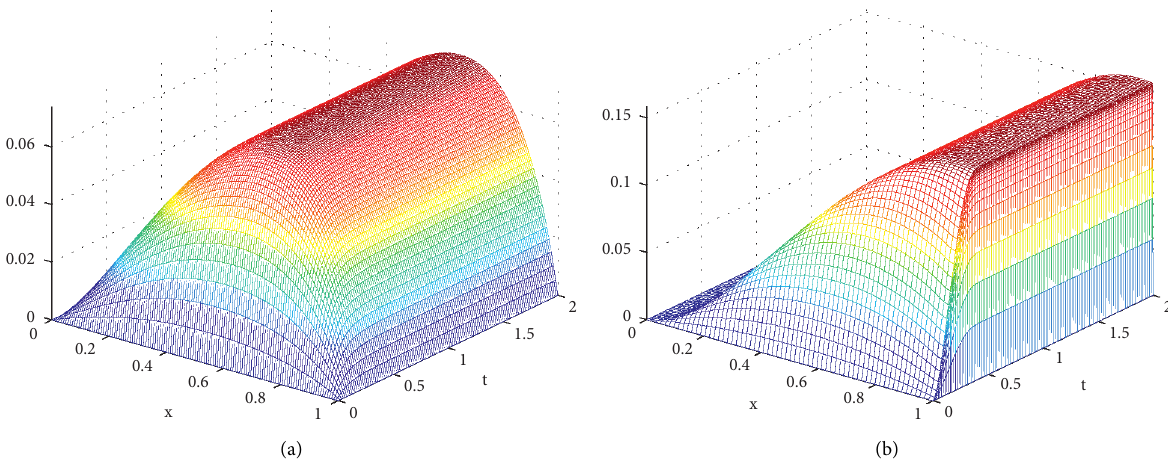
Figure 3: 3D view of solution of Example 2, with boundary layer, on (a) ε � 1 and (b) ε � 2 − 20